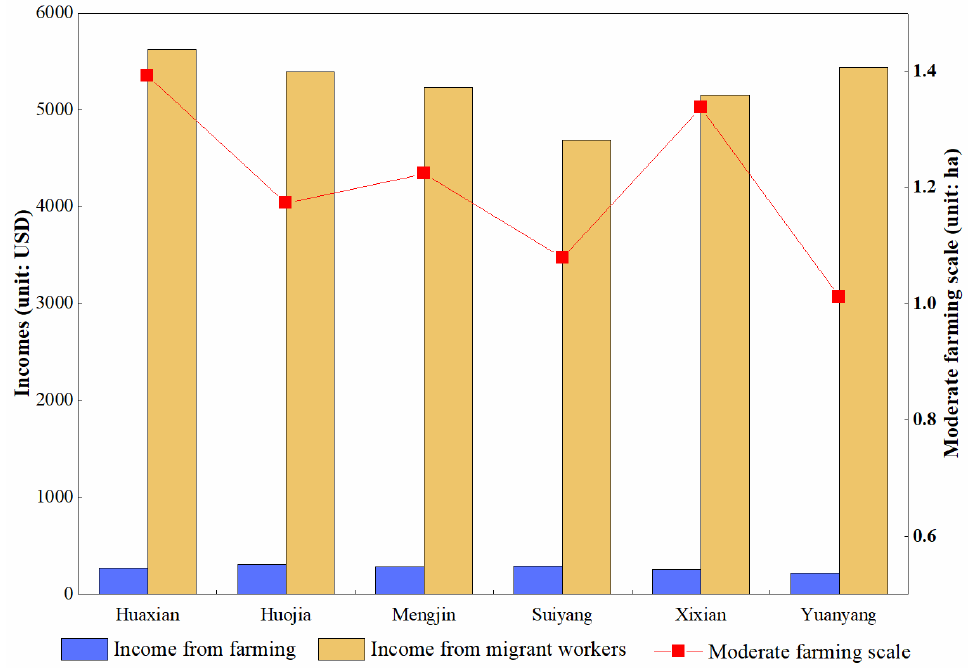
Figure 4. The moderate farming scale under opportunity cost.